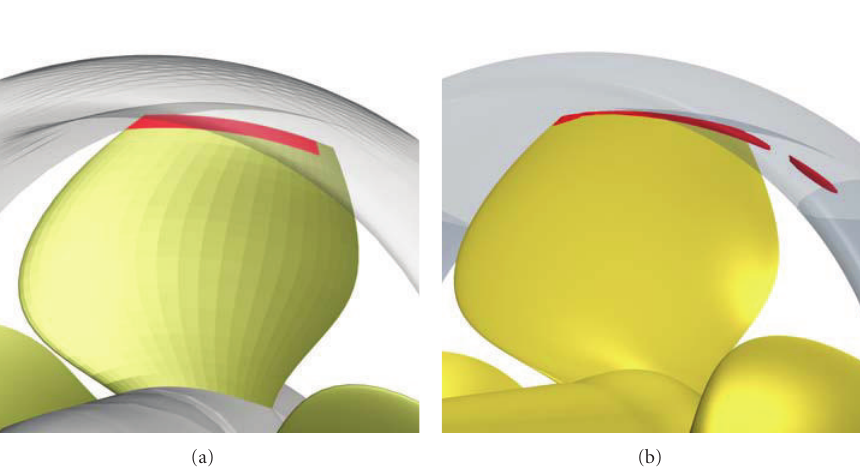
Figure 9: Predicted cavity extension for the optimized propeller geometry at the design advance coe ffi cient. (a) Panel method computations at 90% of the design cavitation index. (b) RANS computations at the design cavitation index.